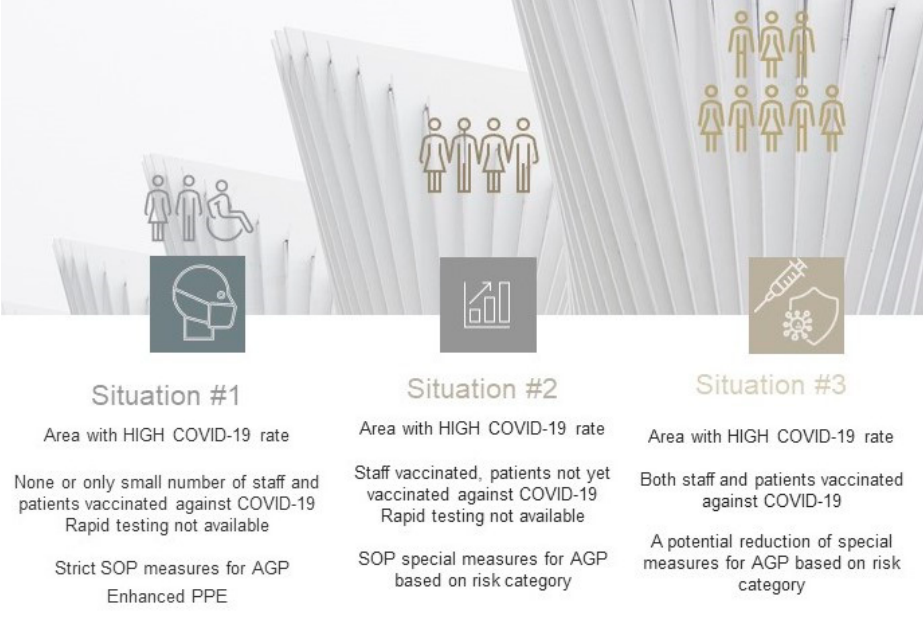
Figure 9. Proposed three-tier system in areas with high COVID-19 cases rate (new waves, local outbreaks) and rapid testing not available. Options for change applicable for SOP in future depending on local COVID-19 cases rate and population immunity status. Unstable COVID-19 rate.